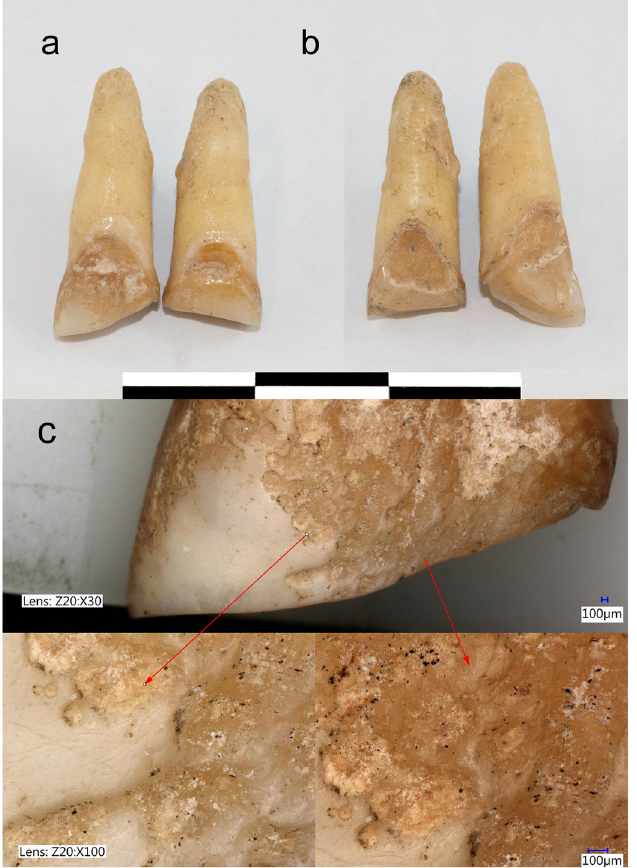
Fig 4. Modified maxillary central incisors of the individual E-92. Modified maxillary central incisors of the individual E-92 from the YC component dated to cal AD 600 – 800: a) labial view; b) lingual view (Photo by W. Hiebert, University of Winnipeg); c) taphonomic changes observed on the labial surface of the modified right maxillary central incisors of the individual E-92 from the YC component dated to cal AD 600 – 800 (images captured by Keyance digital microscope (VHX-5000 series) at 30x and 100x